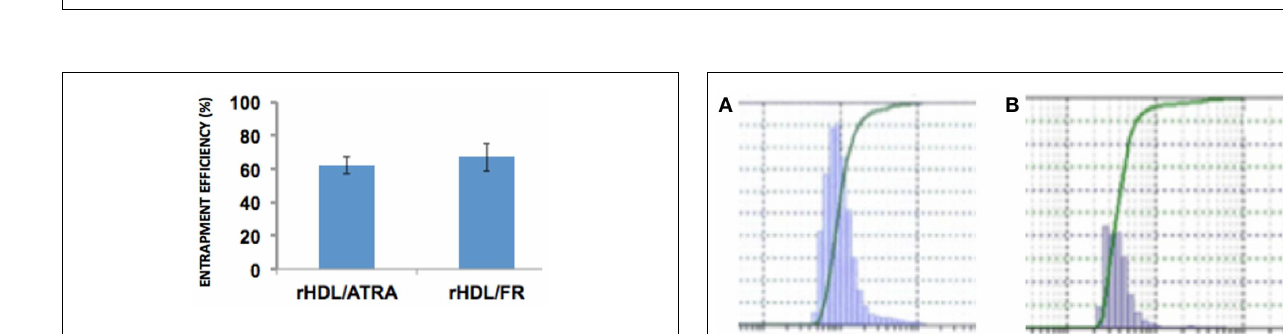
FIGURE 3 | Drug entrapment efficiency of rHDL/ATRA and rHDL/FR nanoparticles.